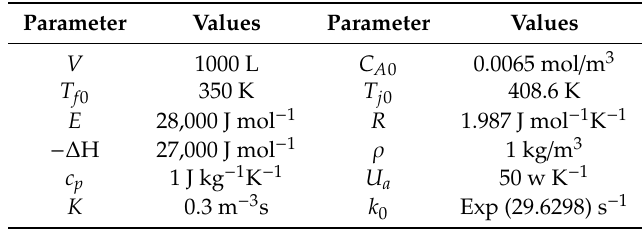
Table 1. Recipe from Douglas’s model [22].